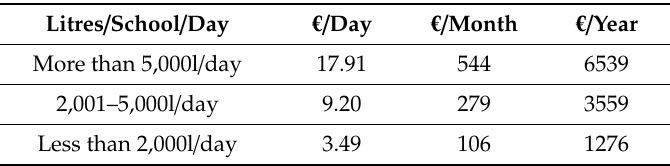
Table 4. Average amount of school water bills (2017) ( € / m 3 ). Litres / School / Day € / Day € / Month € / Year More than 5,000l / day